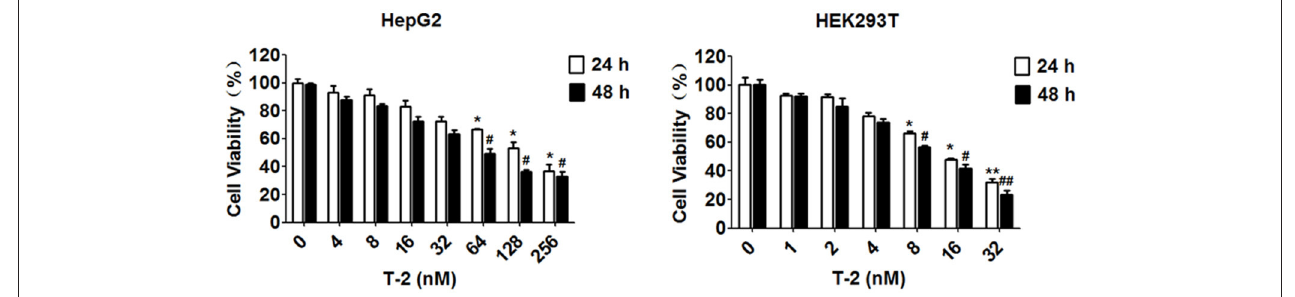
FIGURE 1 | Cell viability assessment using an MTT assay. The IC 50 value of T-2 toxin is 58.95 and 117.4nM in HepG2 cells for 48 and 24h, 10.51 and 15.65nM in HEK293T cells for 48 and 24h. * P < 0.05 for comparison between the control and T-2 toxin-treated for 24h groups. # P < 0.05 for comparison between the the control and T-2 toxin-treated for 48h